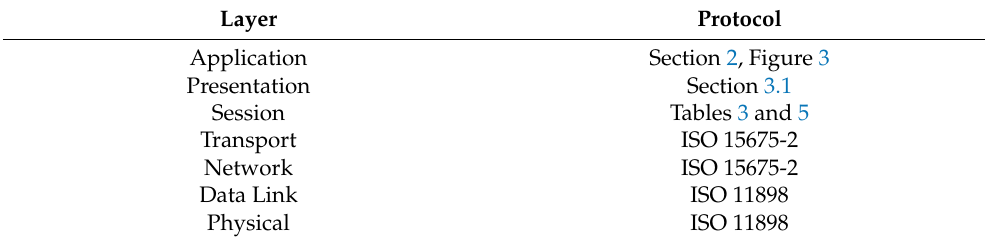
Table 7. OSI model of interconnection of the device and the client by means of the CAN